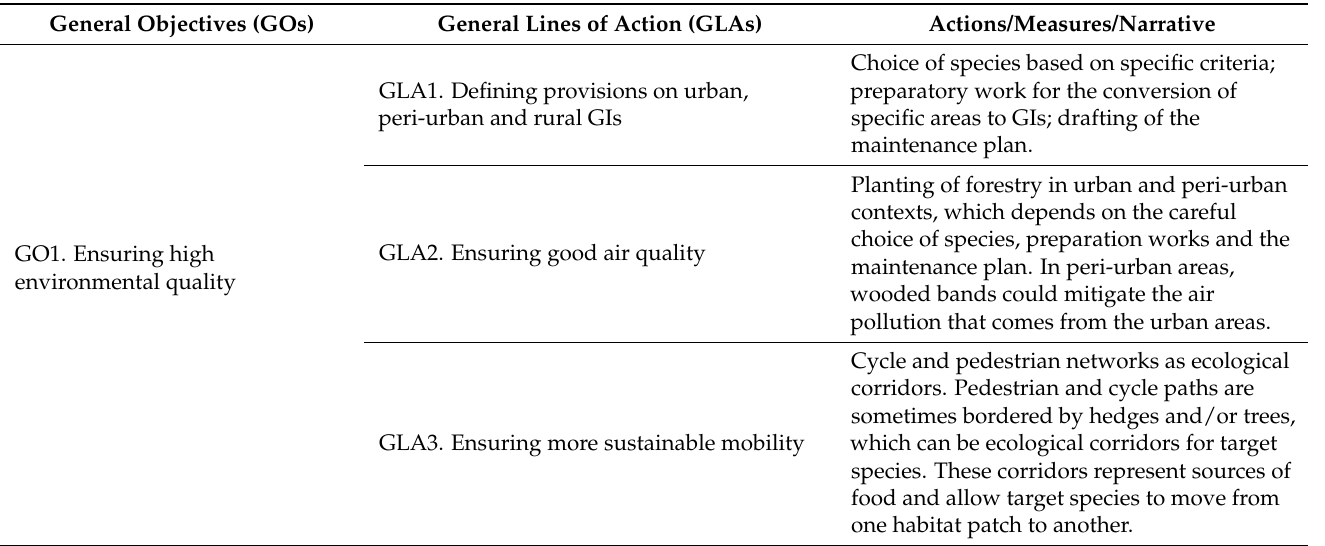
Table 7. Main objectives of green infrastructure planning. General objectives (GOs), general lines of action (GLAs), and the narrative concerning the GI design for the Metropolitan City of Cagliari. General Objectives